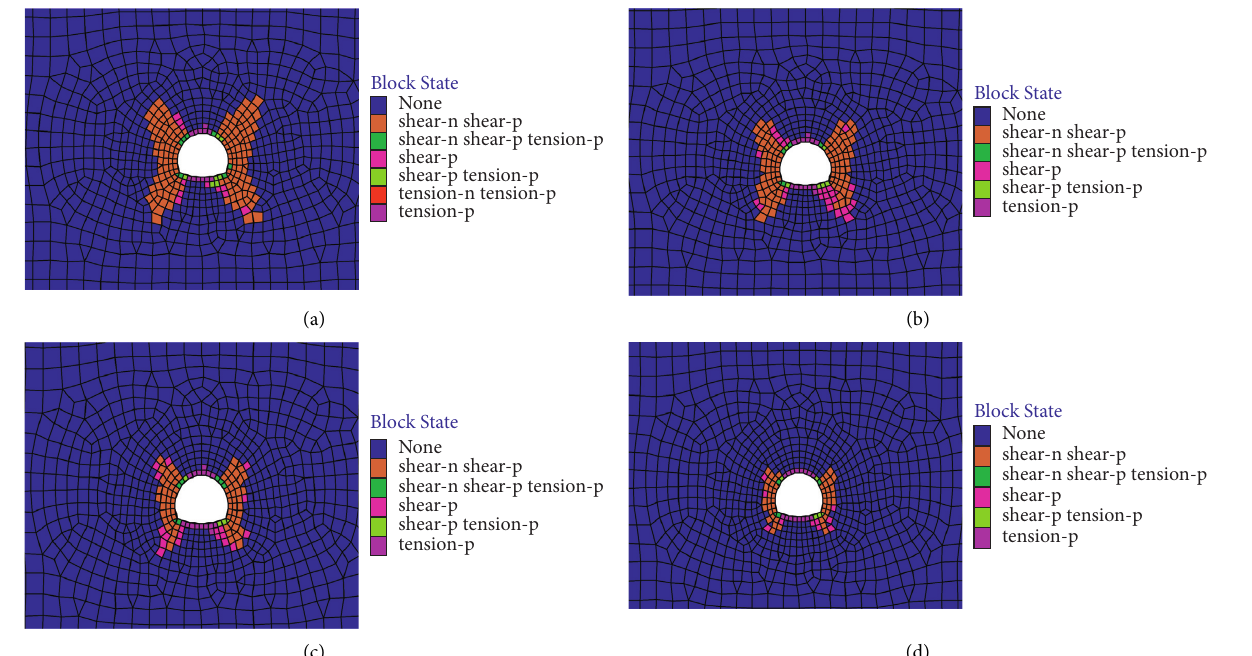
Figure 12: Plastic zone of the tunnel with different support modes. (a) Initial lining. (b) Initial lining +pipe shed. (c) Initial lining+pipe shed+ prestressed anchor rod. (d) Initial lining+pipe shed+advanced grouting anchor rod.